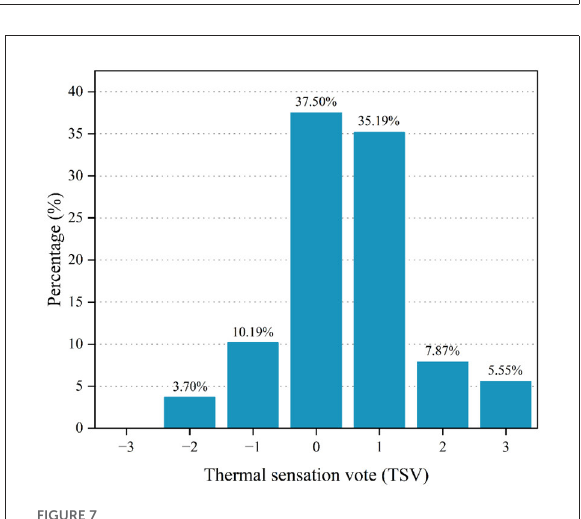
FIGURE7 Result of thermal sensation